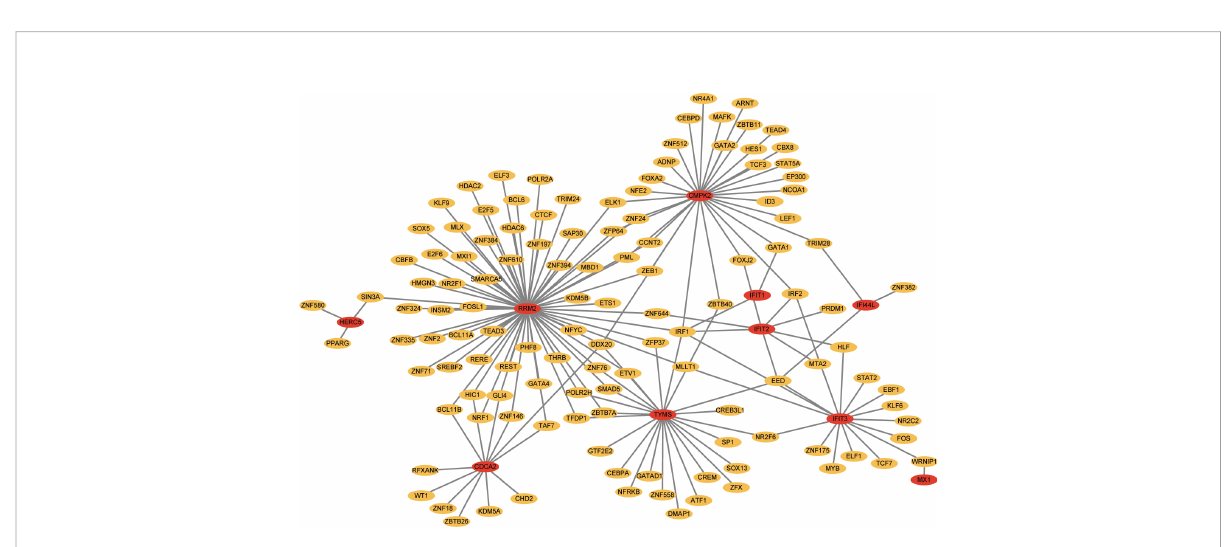
FIGURE 7 Network for TF-gene interaction with hub genes. The highlighted blue color node represents the hub genes and other nodes represent